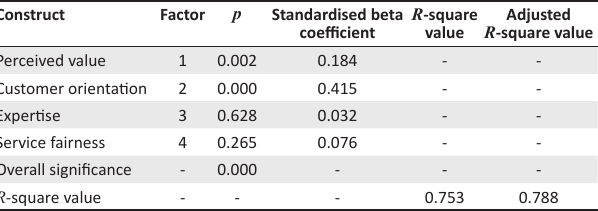
TABLE 6: Influence of the independent variables (perceived value, customer orientation, expertise and service fairness) on affective commitment. Construct